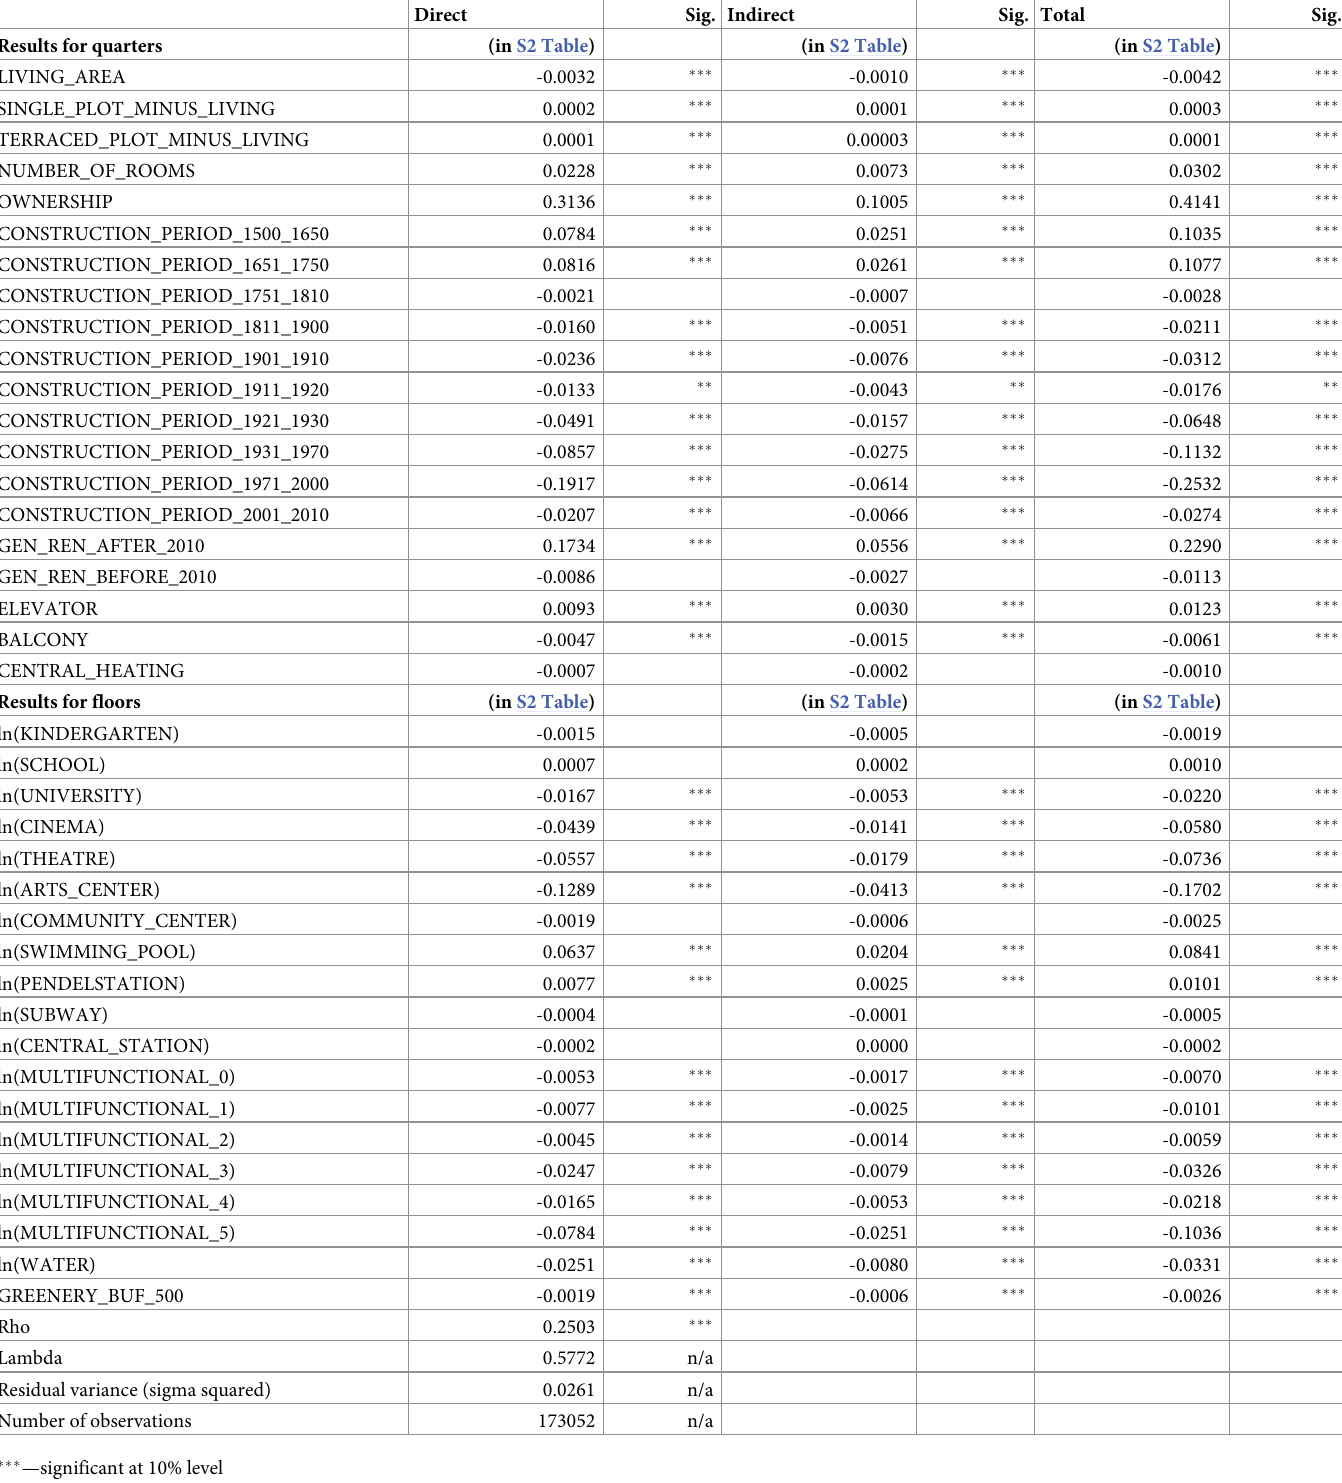
Table 4. Results of the second stage of the study (focused on the multifunctionality of green spaces). Direct Sig. Indirect Sig. Total